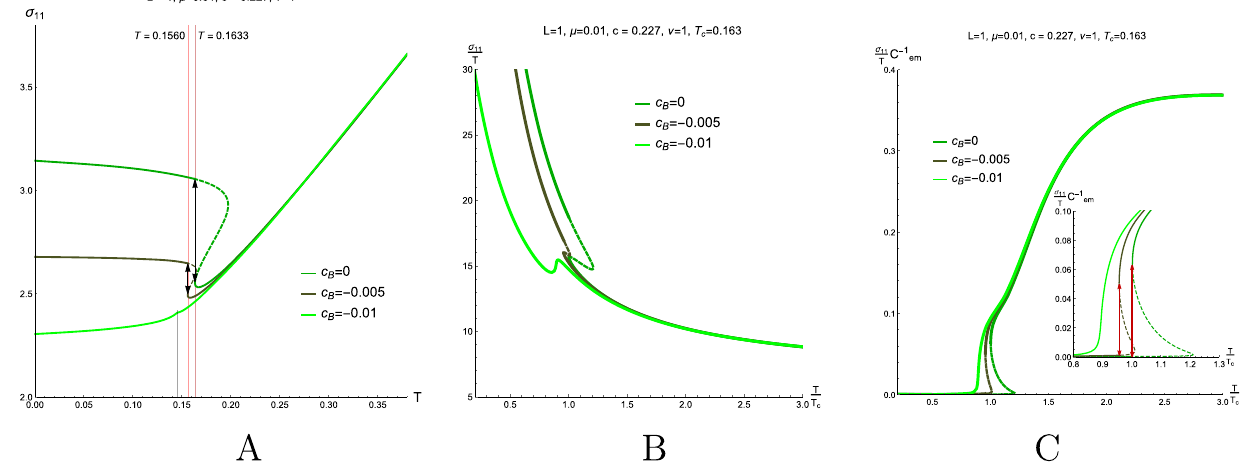
Fig. 6 A Thedependenceof σ 11 onthetemperature T ispresentedwith the dilaton coupling f 0 (φ) = 1. B The dependence of the ratio σ 11 / T on the temperature T is presented with the dilaton coupling f 0 (φ) = 1.